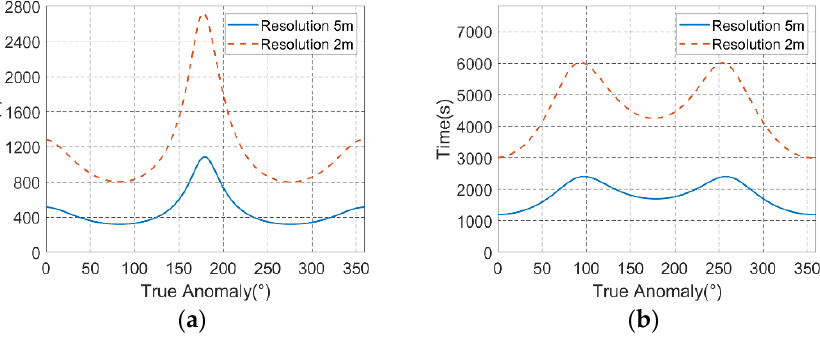
Figure 4. GEO SAR integration time. ( a ) “8” shaped orbit; and ( b ) near-circular